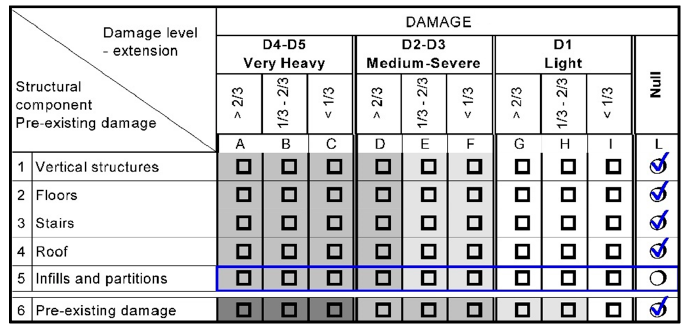
Figure 5. Damage description according to the AeDES forms and analysed damage—adapted from Baggio et al. [4]. Buildings 2019 , 9 , x FOR PEER REVIEW